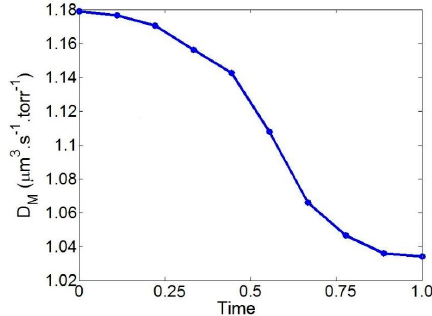
Figure 5. The time history of D M during the deformation of a single RBC. The time is normalized with a total time of 0.8 s.